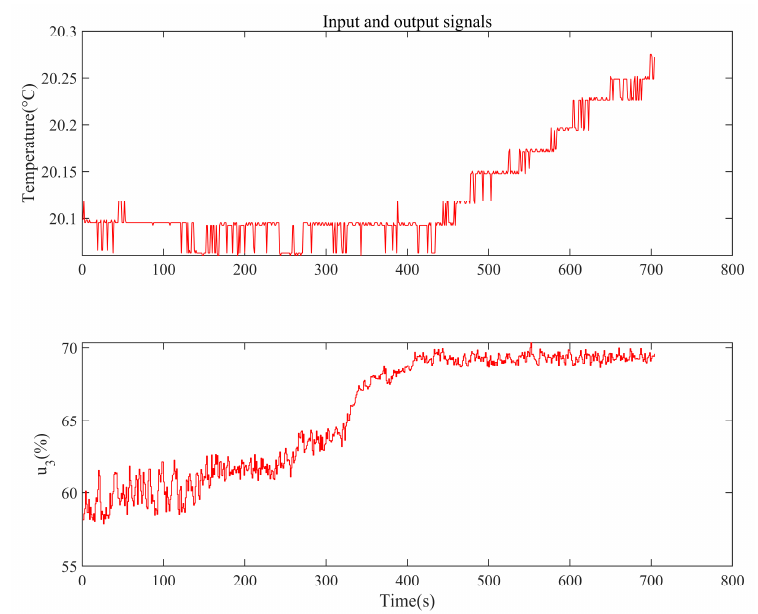
Figure 7. Feedback of solenoid valve DN300 and inlet temperature of cold module.